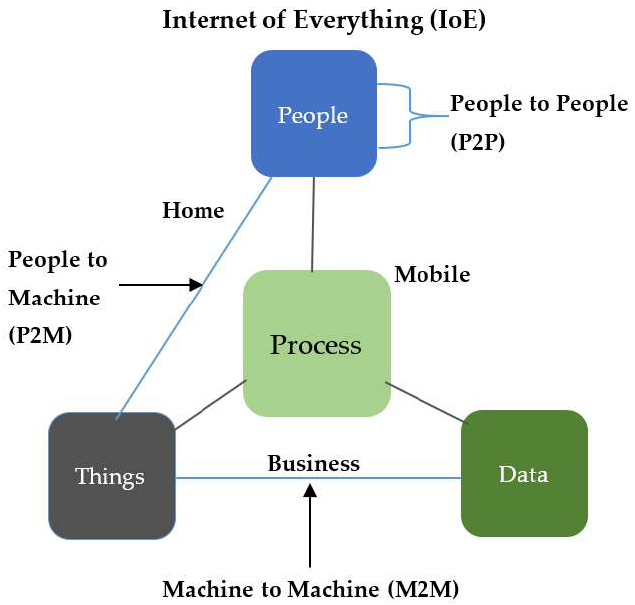
Figure 4. Internet of Everything (IoE). Adapted from [10].